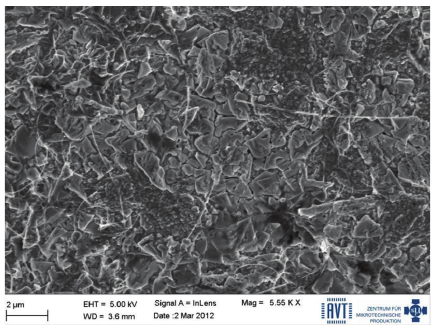
Figure 3: SEM Image depicting randomly oriented CNT in Cu ma- trix.